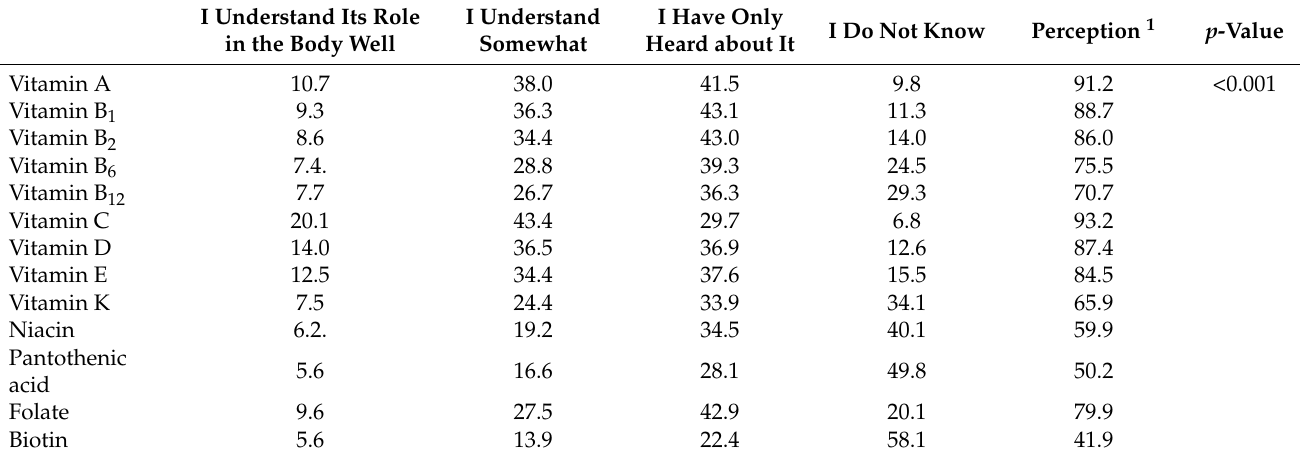
Table 6. The perception of each